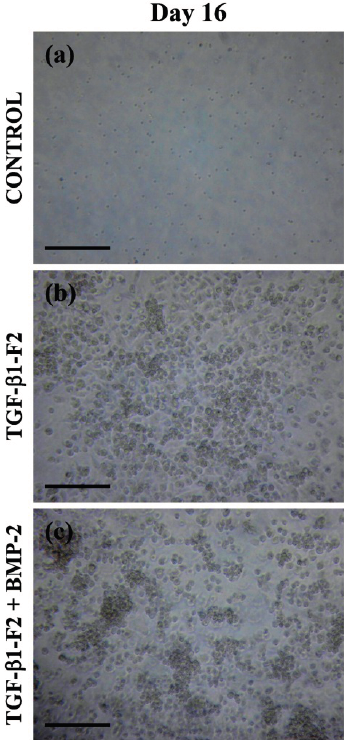
Figure 2. Cell morphology in 3D (three-dimensional) collagen matrix at the end of differentiation period (day 16). ( a ) Control cultures in the absence of growth factor; ( b ) Cell cultures in presence of rhTGF- β 1-F2; and ( c ) Cell cultures in presence of rhTGF (recombinant human transforming growth factor)- β 1-F2 and the pulse of rhBMP (recombinant human bone morphogenetic protein)-2. Bars, 200 μ